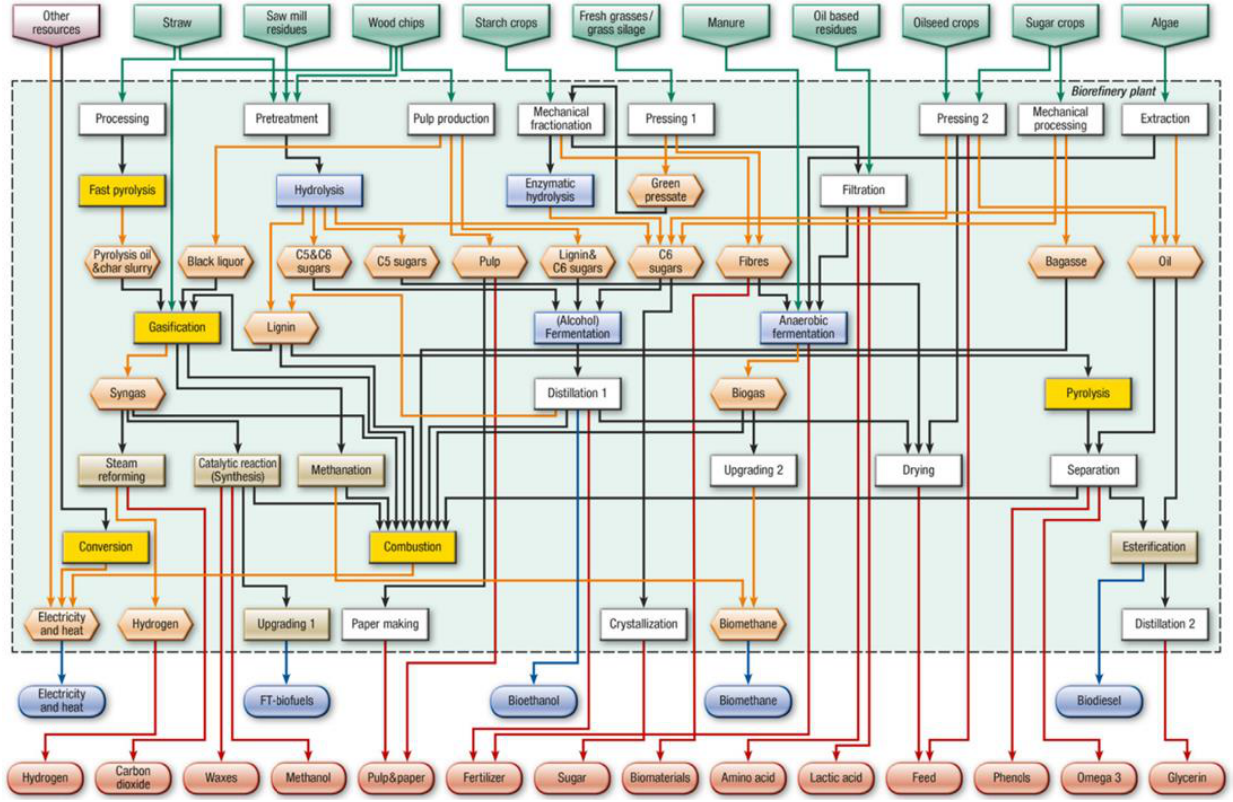
Figure 1. Conceptual scheme describing the relationships between the most promising existing and developing individual biorefinery systems (Adapted with permission from Ref. [42]. 2009, John Wiley & Sons).